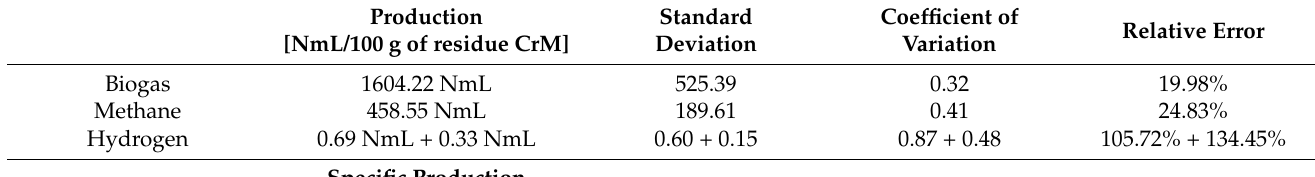
Table 3. Numerical results of the BMP tests when digestion residue CrM. Gross and specific production of biogas, methane and hydrogen, methane and hydrogen content of the produced biogas and descriptive